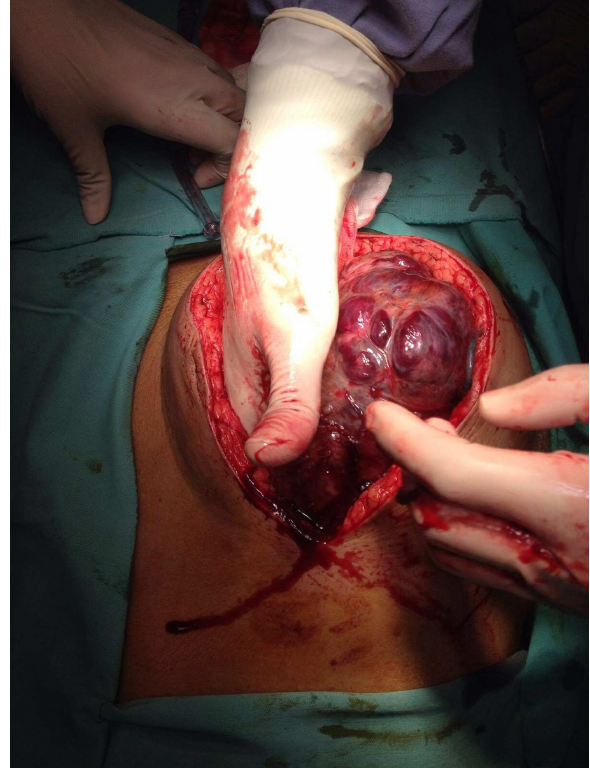
Figure 1: Grossly large gastrointestinal stromal tumor with irregular borders and